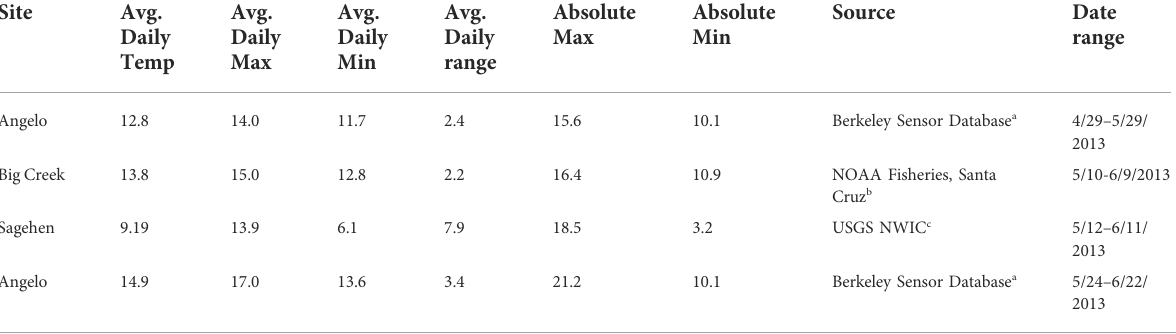
TABLE 1 Stream temperatures in the fi eld for 30 days before collection ( °